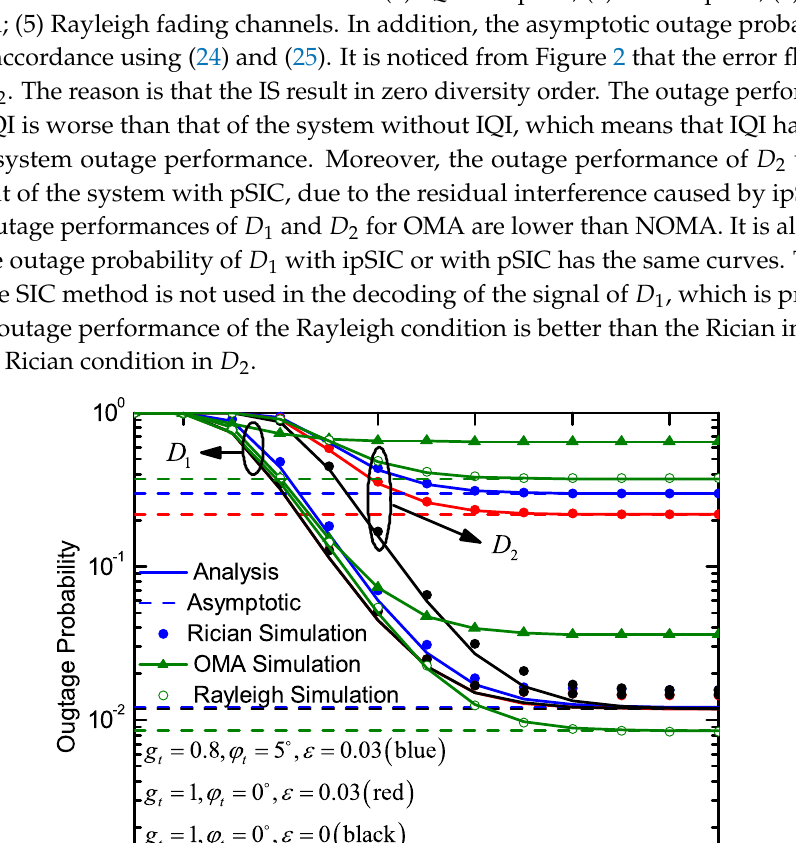
An excellent agreement can be observed between the analytical results and Monte Carlo simulations.